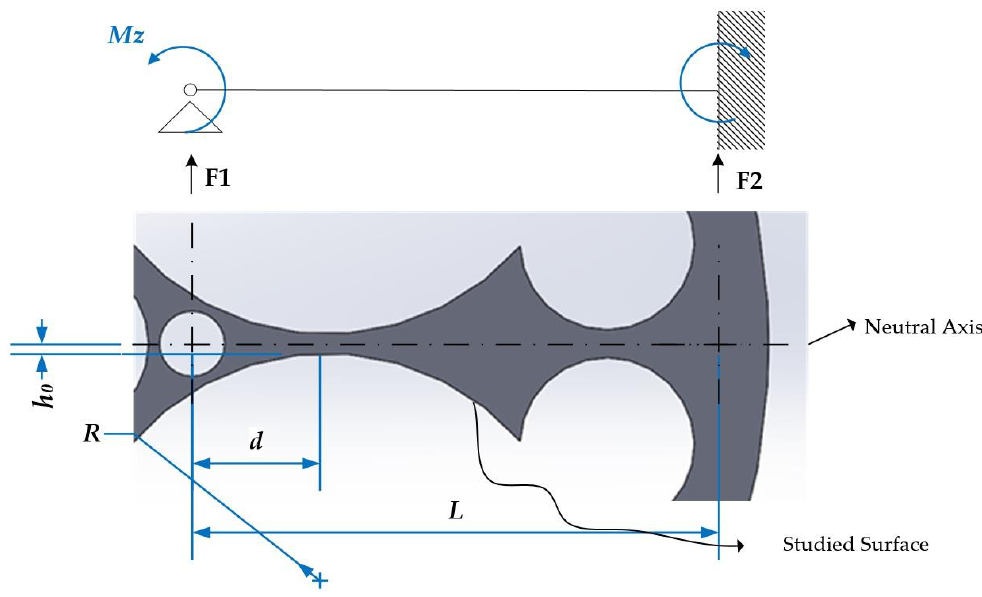
Figure 7. Mechanical model of an elastic body under Mz.